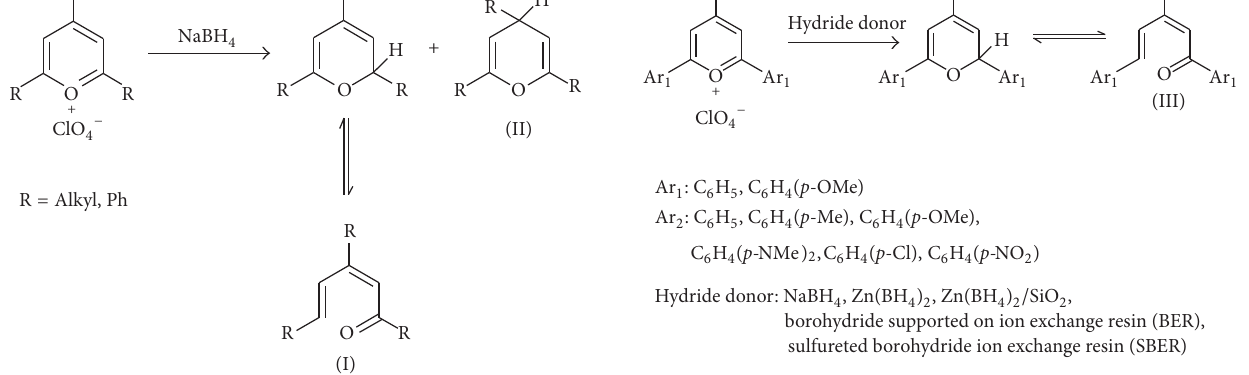
S 2: Regiospeci�c reduction of triarylpyrylium salts in the presence of various hydride